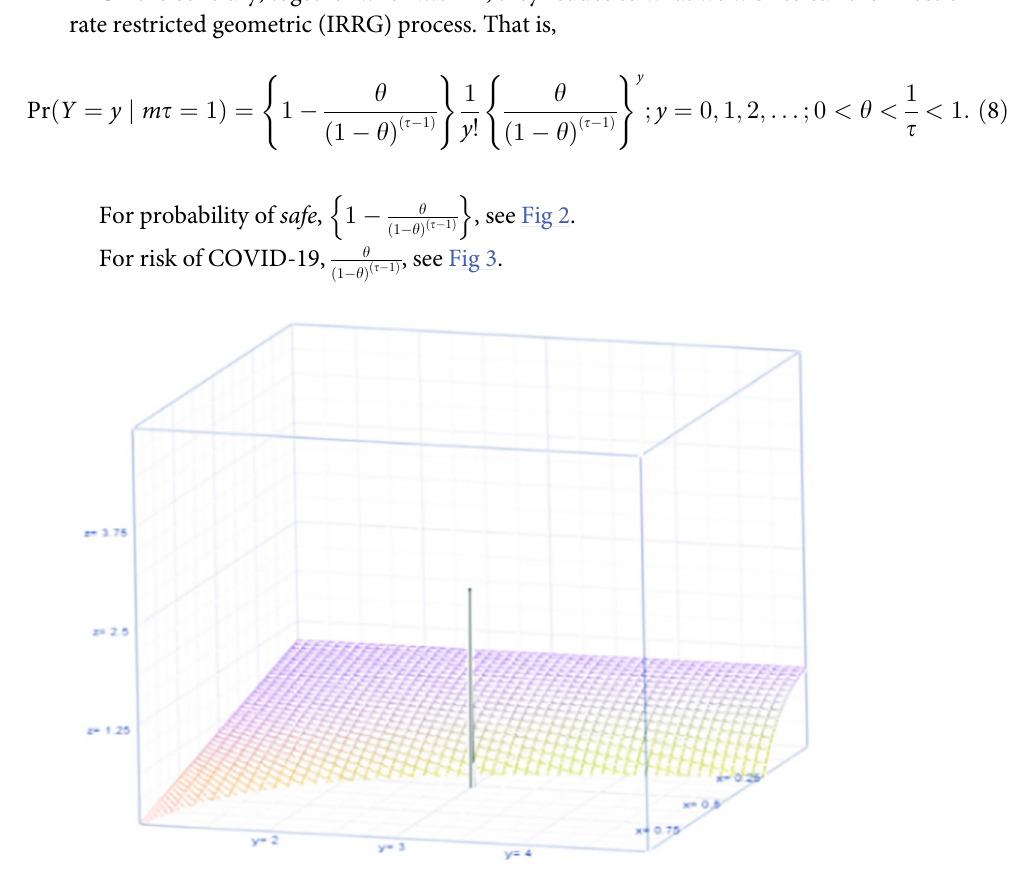
Fig 2. Probability of being